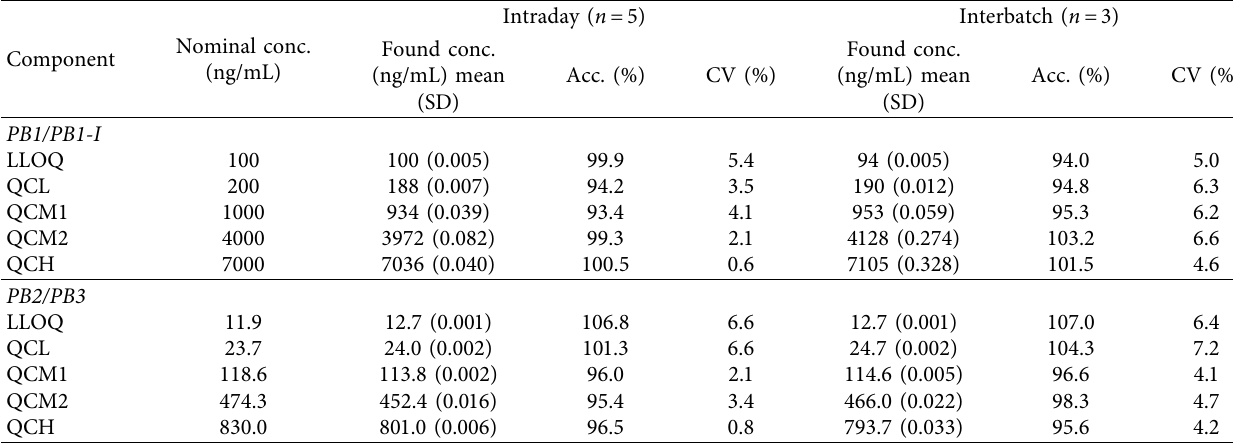
Table 3: Intrabatch and interbatch precision and accuracy for PB in